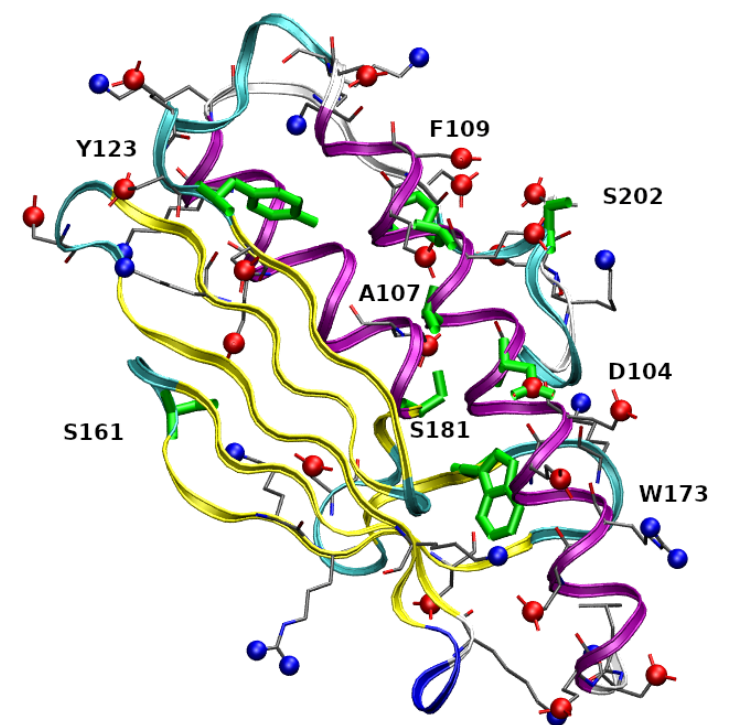
Figure 1. Structure of FXN residues 90-210 in 1EKG crystal. Ribbons interpolate main-chain atoms, with color according to the STRIDE algorithm [19]; β -strands are in yellow; α -helices are purple. Residues that are mutated (with labels) are in green. Red spheres are C in carboxylate groups. Blue spheres are N in ammonium and guanidinium groups. Atomic and bond radii are arbitrary. The VMD program [20] is used for molecular